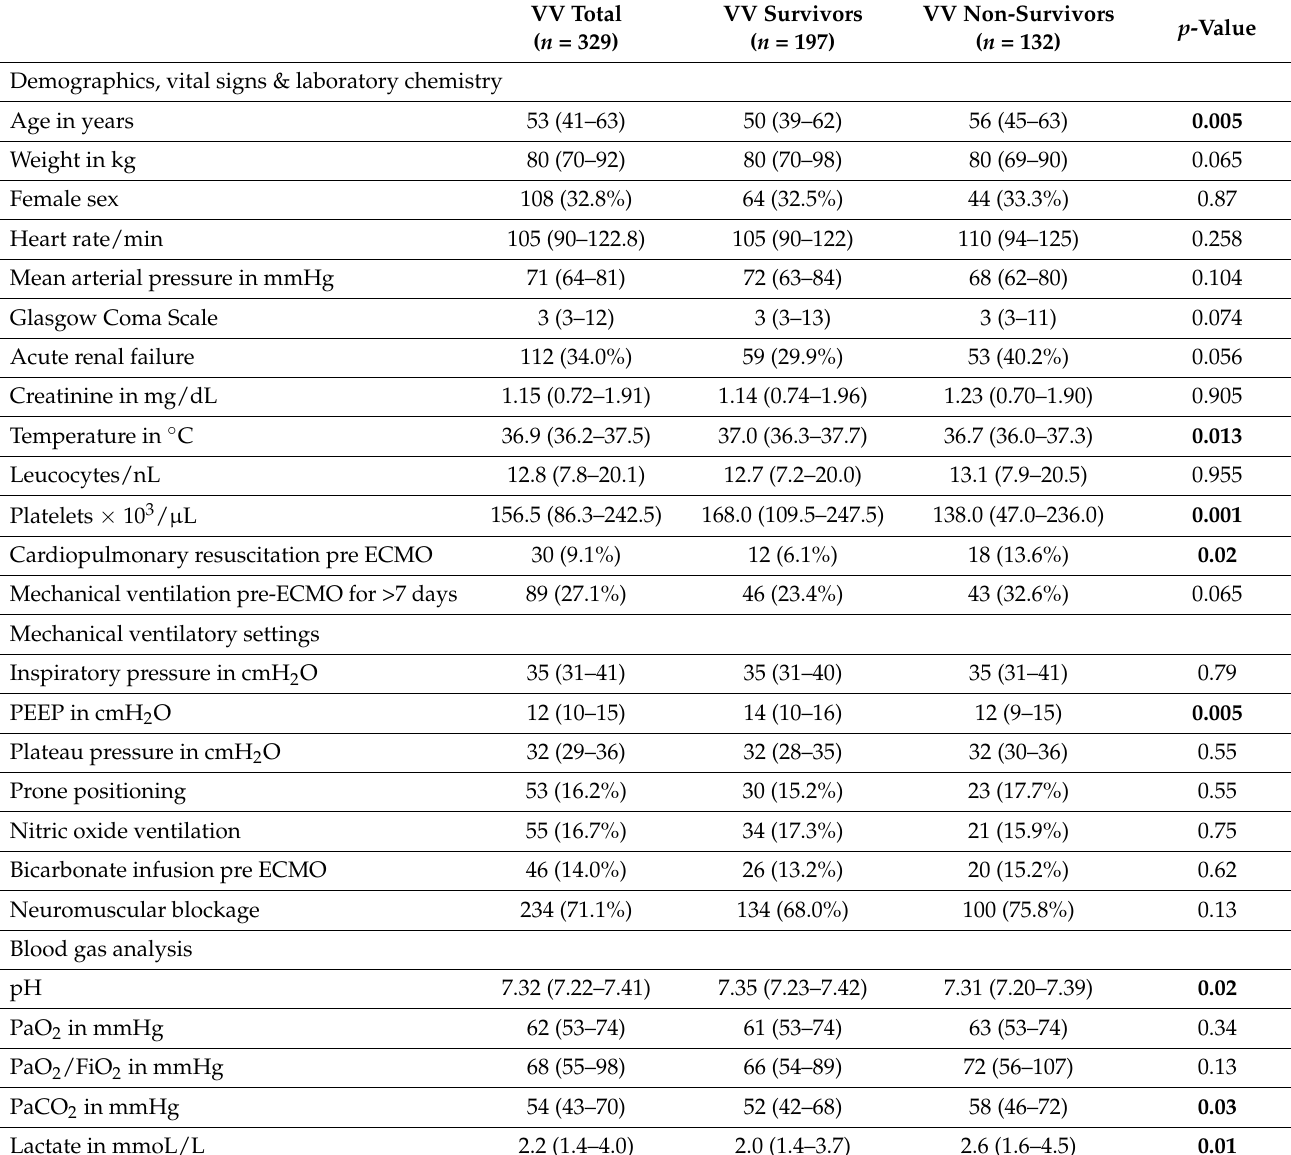
Table 3. Patient characteristics on patients on ECMO before implantation according to survival (veno-venous ECMO cohort).